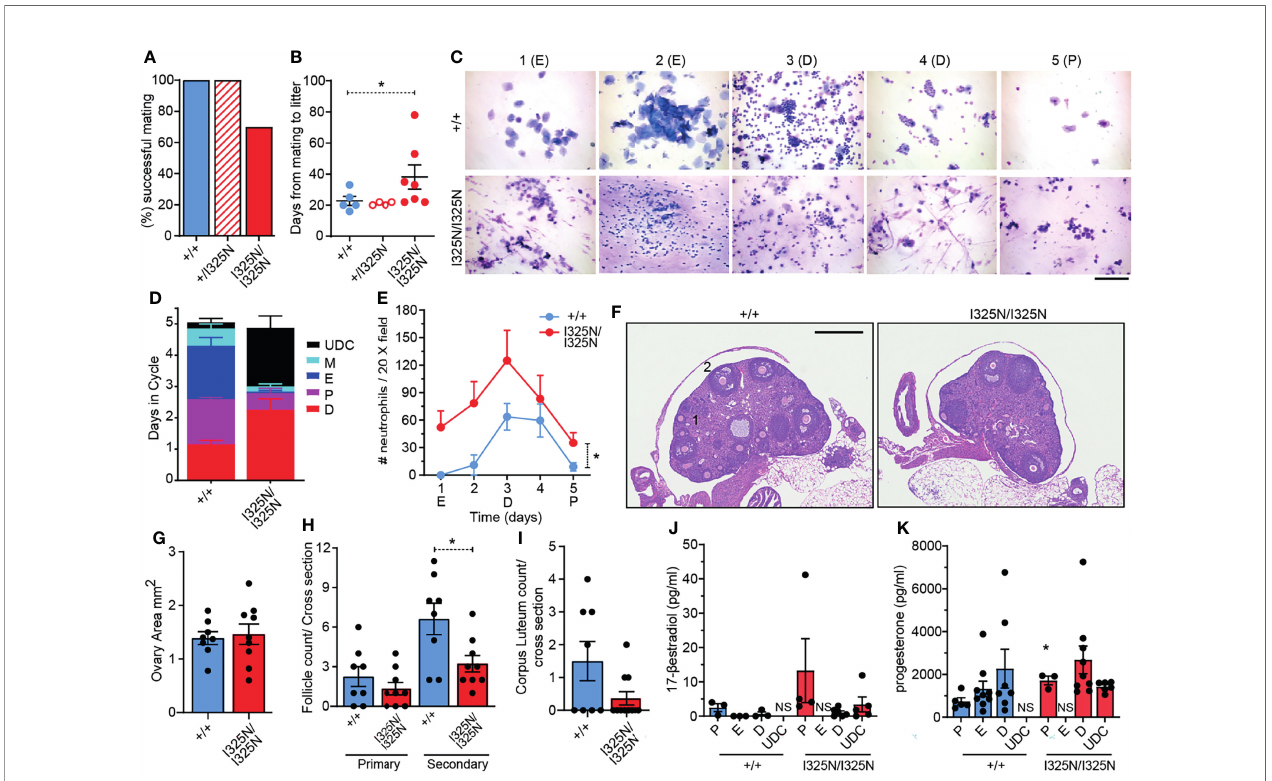
FIGURE 1 | Tnfaip3 I325N drives ovarian dysfunction in homozygous mice. Adult (8-12 weeks) female mice of the indicated genotypes were paired with a similar aged wild-type males and (A) successful mating and (B) time to litter recorded over a 100 day period. ( n = 5 Tnfaip3 +/+ , 4 Tnfaip3 +/I325N and 10 Tnfaip3 I325N/I325N ). (C) Diff- Quick stain of vaginal smears over 5 days (D1-D5) from female mice induced to synchronous estrous at 5 weeks of age [Whitten effect (27)]. Data is representative of 1 box of 8 week old mice from 3 independently housed groups ( n = 5 Tnfaip3 +/+ and 6 Tnfaip3 I325N/I325N ). Determined cycle stage for wild-type smears is indicated in parenthesis; E = estrous, D = diesterous, P = proesterous. (D) Days spent in each cycle-stage cumulated from all groups in (C) . (E) The average number of neutrophils identi fi ed in a 20X fi eld view of vaginal smears taken in (C) Neutrophil count was determined for each slide by numerating and averaging neutrophil number from fi ve random 20X fi eld of views. Counts for 1 full cycle were averaged against counts from 4 additional cycles from the same mouse. (F) Representative H&E sections of ovaries from cycling Tnfaip3 I325N mice of the indicated genotypes. Primary follicles and secondary follicles indicated by 1 and 2 respectively. Scale = 500 µm. (G) Ovarian area, (H) primary and secondary follicle and (I) corpus luteum counts per cross sectional area for Tnfaip3 +/+ and Tnfaip3 I325N/I325N ovaries. Each point represents an individual ovary. (J) 17- b estradiol and (K) progesterone ELISA from serum of cycling mice (n ≥ 3). Error bars represent s.e.m and One-Way Anova (B) , (D) Area under the curve or Student ’ s T test (G – K) used for signi fi cance analysis * = P < 0.05. UDC = unde fi ned cycle; NS = no